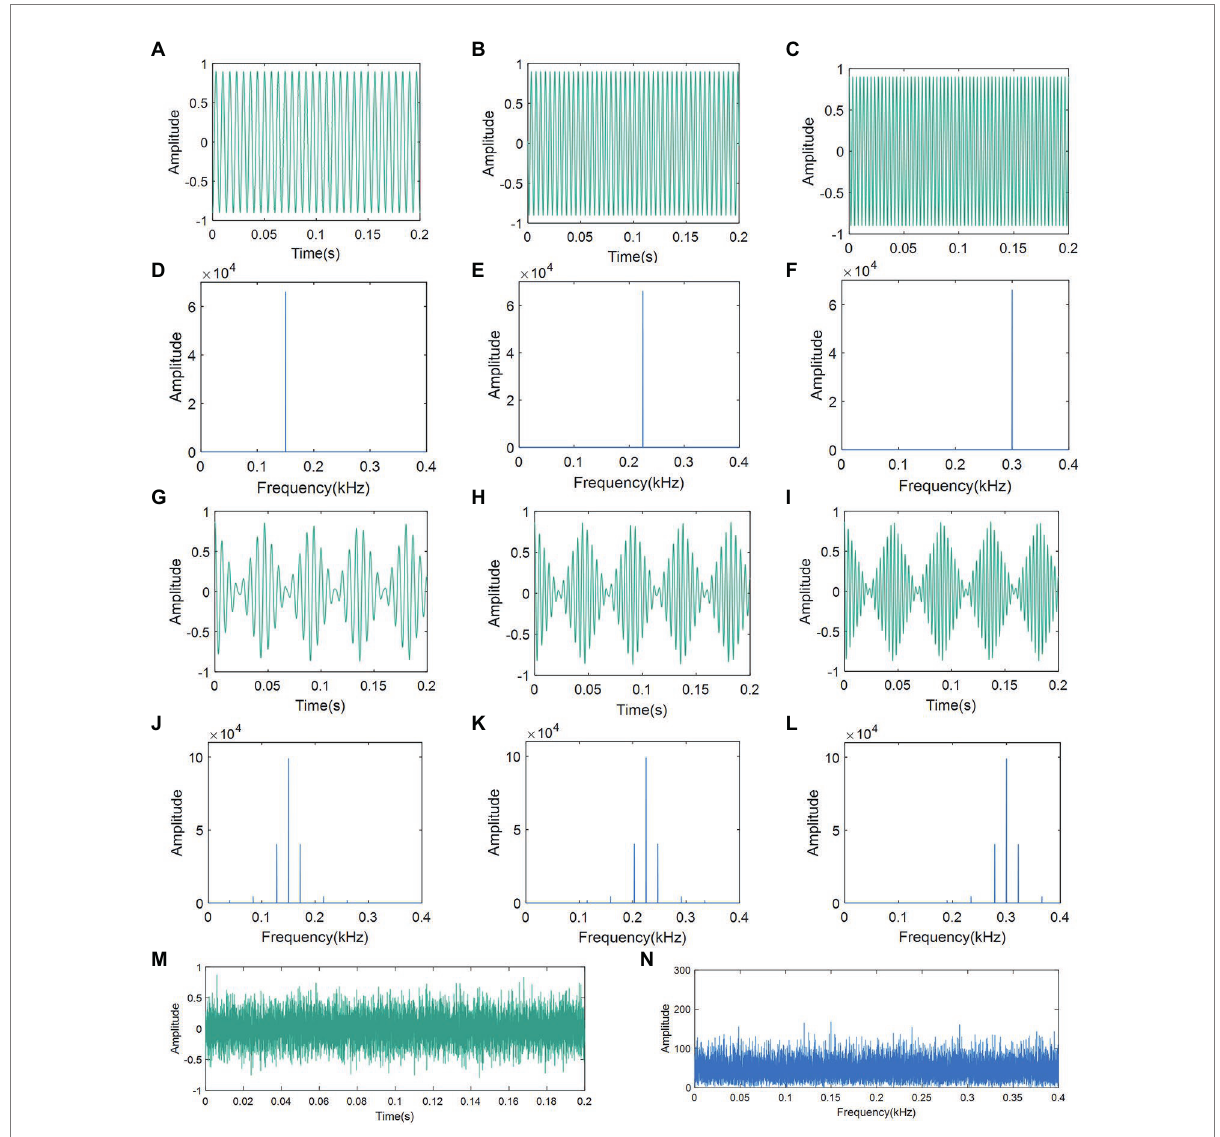
FIGURE 3 Oscillograms and spectrograms of artificial disruptive signals: (A) Oscillogram of PT (150 Hz); (B) Oscillogram of PT (225 Hz); (C) Oscillogram of PT (300 Hz); (D) Spectra of PT (150 Hz); (E) Spectra of PT (225 Hz); (F) Spectra of PT (300 Hz); (G) Oscillogram of CPS (22-150 Hz); (H) Oscillogram of CPS (22-225 Hz); (I) Oscillogram of CPS (22-300 Hz); (J) Spectra of CPS (22-150 Hz); (K) Spectra of CPS (22-225 Hz); (L) Spectra of CPS (22-300 Hz); (M) Oscillogram of WGN; and (N) Spectra of WGN. PT: pure tone; CPS: continuous pulse signal; WGN: white Gaussian